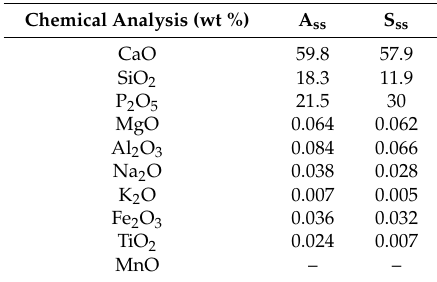
Table 1. Results of the X-ray fluorescence chemical analysis of Nurse’s A and silicocarnotite synthetic powders.